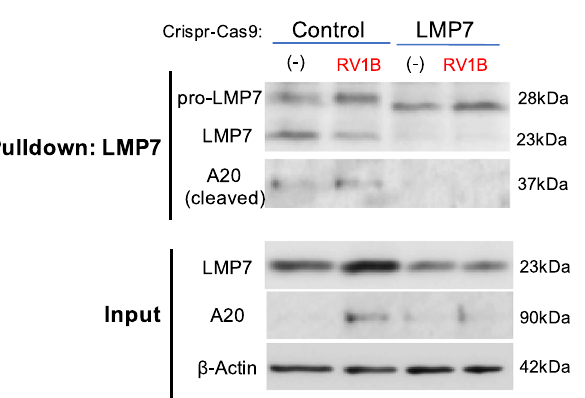
Figure 8. Immunoproteasome subunit LMP7 interacts with A20 in Control CRISPR cells . HTBE cells transduced with lentivirus containing the LMP7 sgRNA or scramble control (Control) plasmid construct were infected with 5 × 10 3 PFU/well RV1B or 0.1% BSA-PBS (−) in submerged culture. Immunoblot of LMP7, A20 and β-Actin was done after performing an immunoprecipitation with